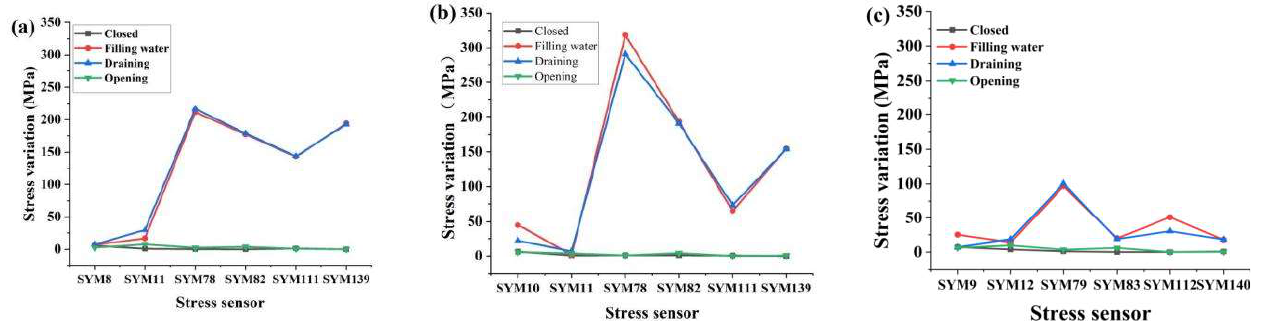
Figure 9. Stress variation at locations of ( a ) longitudinal rear wing flange; ( b ) transverse rear wing flange; ( c ) crossed rear wing flange under different working conditions.